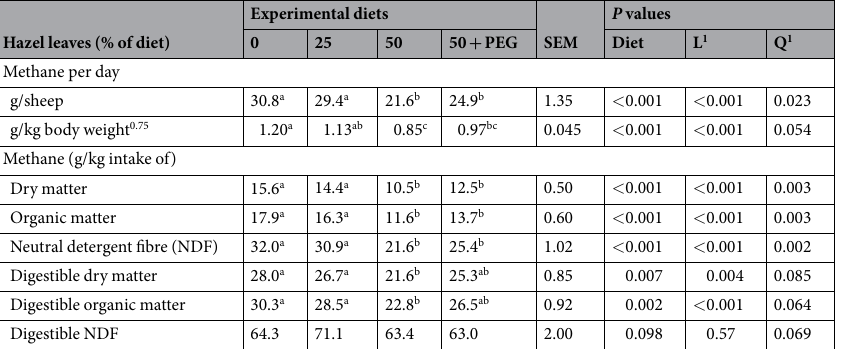
Table 3. Effect of hazel leaves on enteric methane emission of the sheep (n = 6). L, linear effect of hazel leaf proportion; PEG, polyethylene glycol; Q, quadratic effect of hazel leaf proportion; SEM, standard error of mean. Means carrying no common superscript are different at P < 0.05. 1 For this analysis, only diets 0, 25 and 50 were compared.